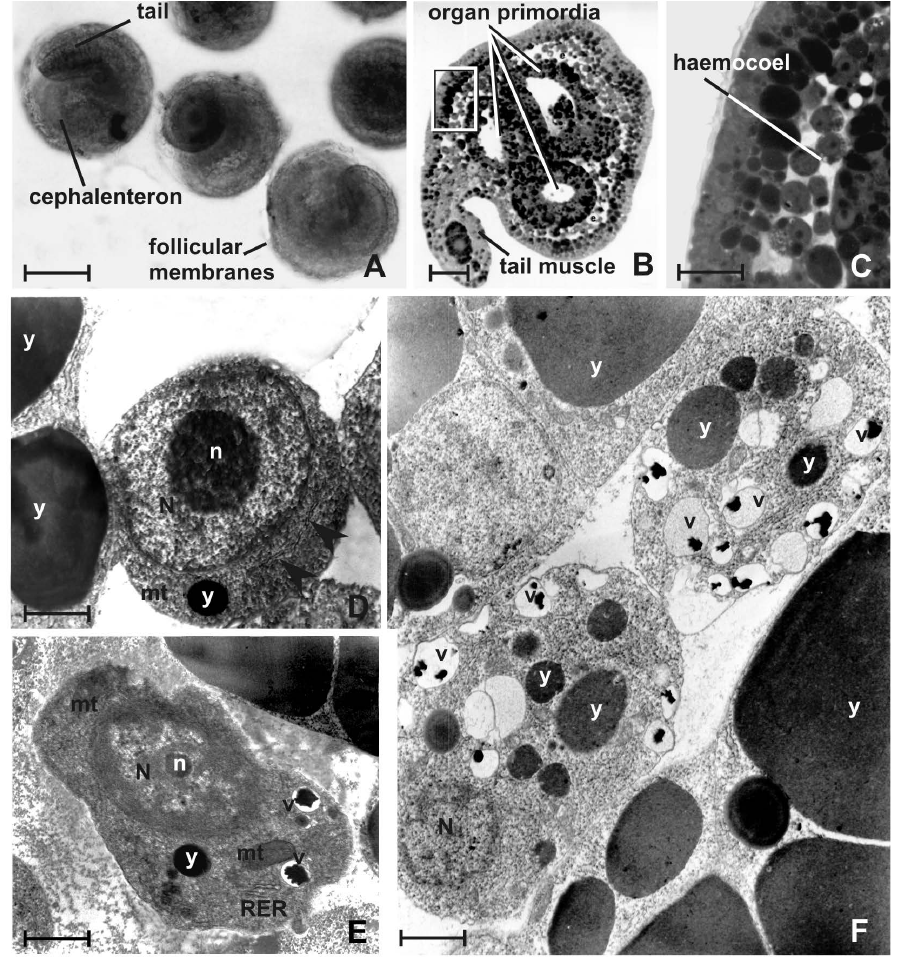
Figure 2. Early tailbud embryos: ( A ) embryos collected from parental zooids of the colony and viewed in toto; ( B ) longitudinal thick section of an embryo stained with toluidine blue; ( C ) detail of ( B ) showing numerous haemocytes in the haemocoel; ( D ) haemoblast showing scant cisternae of RER ( arrowheads ), mitochondria and yolk granules in the cytoplasm; and ( E , F ) putative precursors of morula cells with small vacuoles containing electron-dense aggregates. mt —mitochondrion, N —nucleus, n —nucleolus, v —vacuole, and y —yolk granule. Bar length: 150 µ m in ( A ); 30 µ m in ( B ); 10 µ m in ( C ); 1.4 µ m in ( D – F ); and 2 µ m in ( E